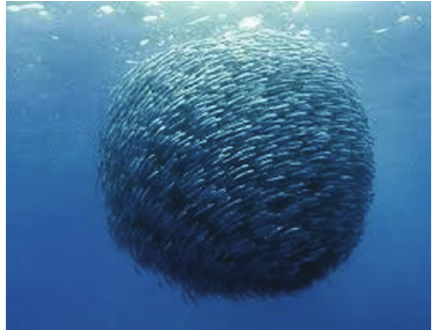
Figure 2: Circular formation in a fish bank. Source: